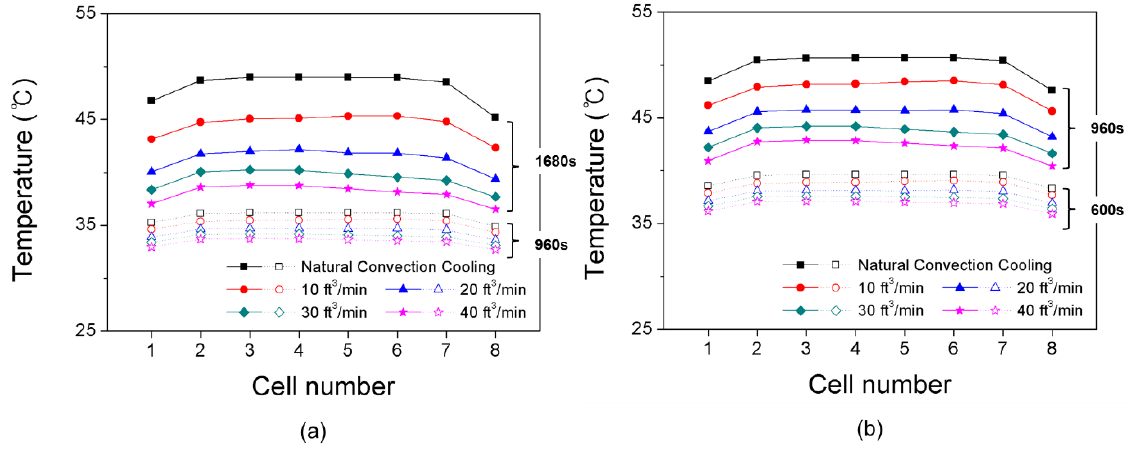
Figure 9. Comparison between the cell temperatures within the module from the experiment and modeling at different discharge times with the discharge rates of ( a ) 2 C and ( b ) 3 C for various cooling conditions.